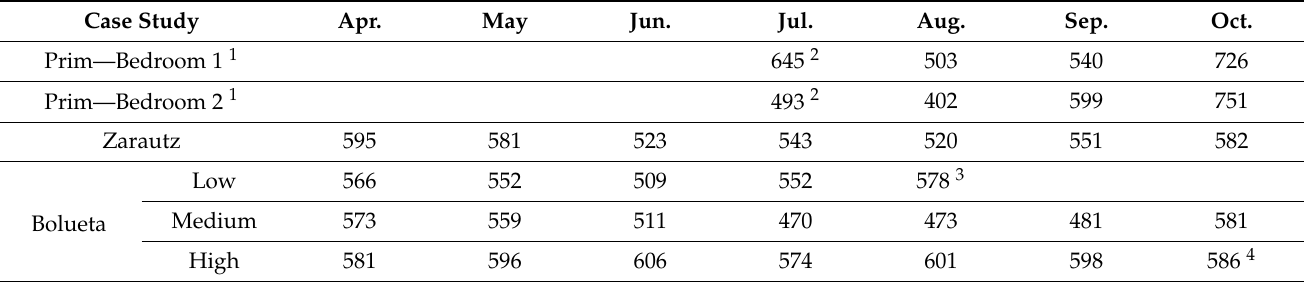
Table 12. Mean CO 2 concentration (ppm), monthly, April–October